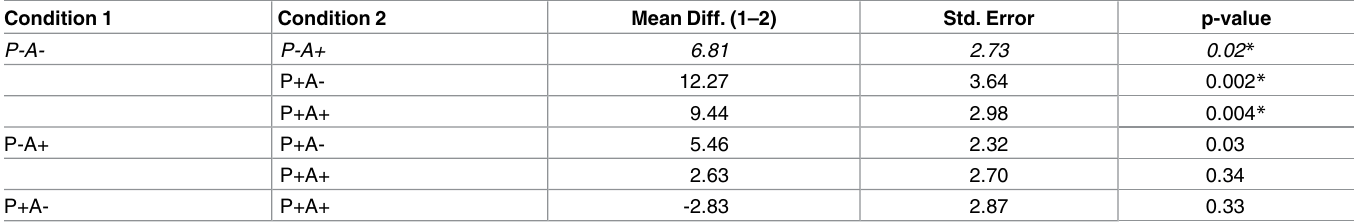
Table 1. Overview of the statistical